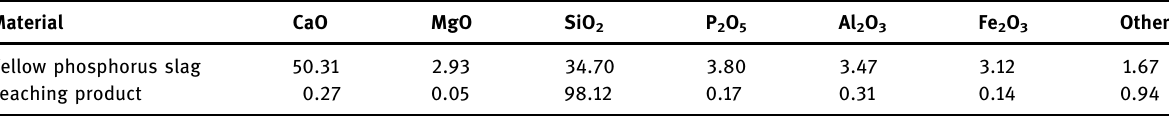
Table 1: Composition of yellow phosphorus slag and leaching product ( wt% )